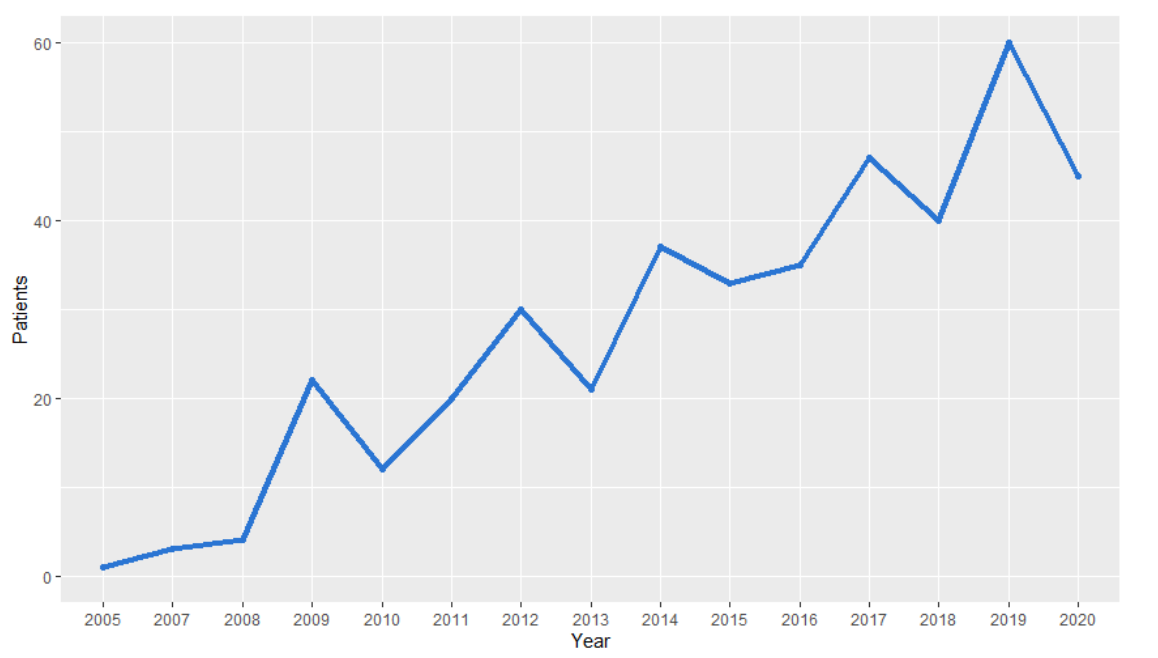
Figure A2. Number of patients referred each year to the Erasmus MC with newly diagnosed melanoma brain metastasis.